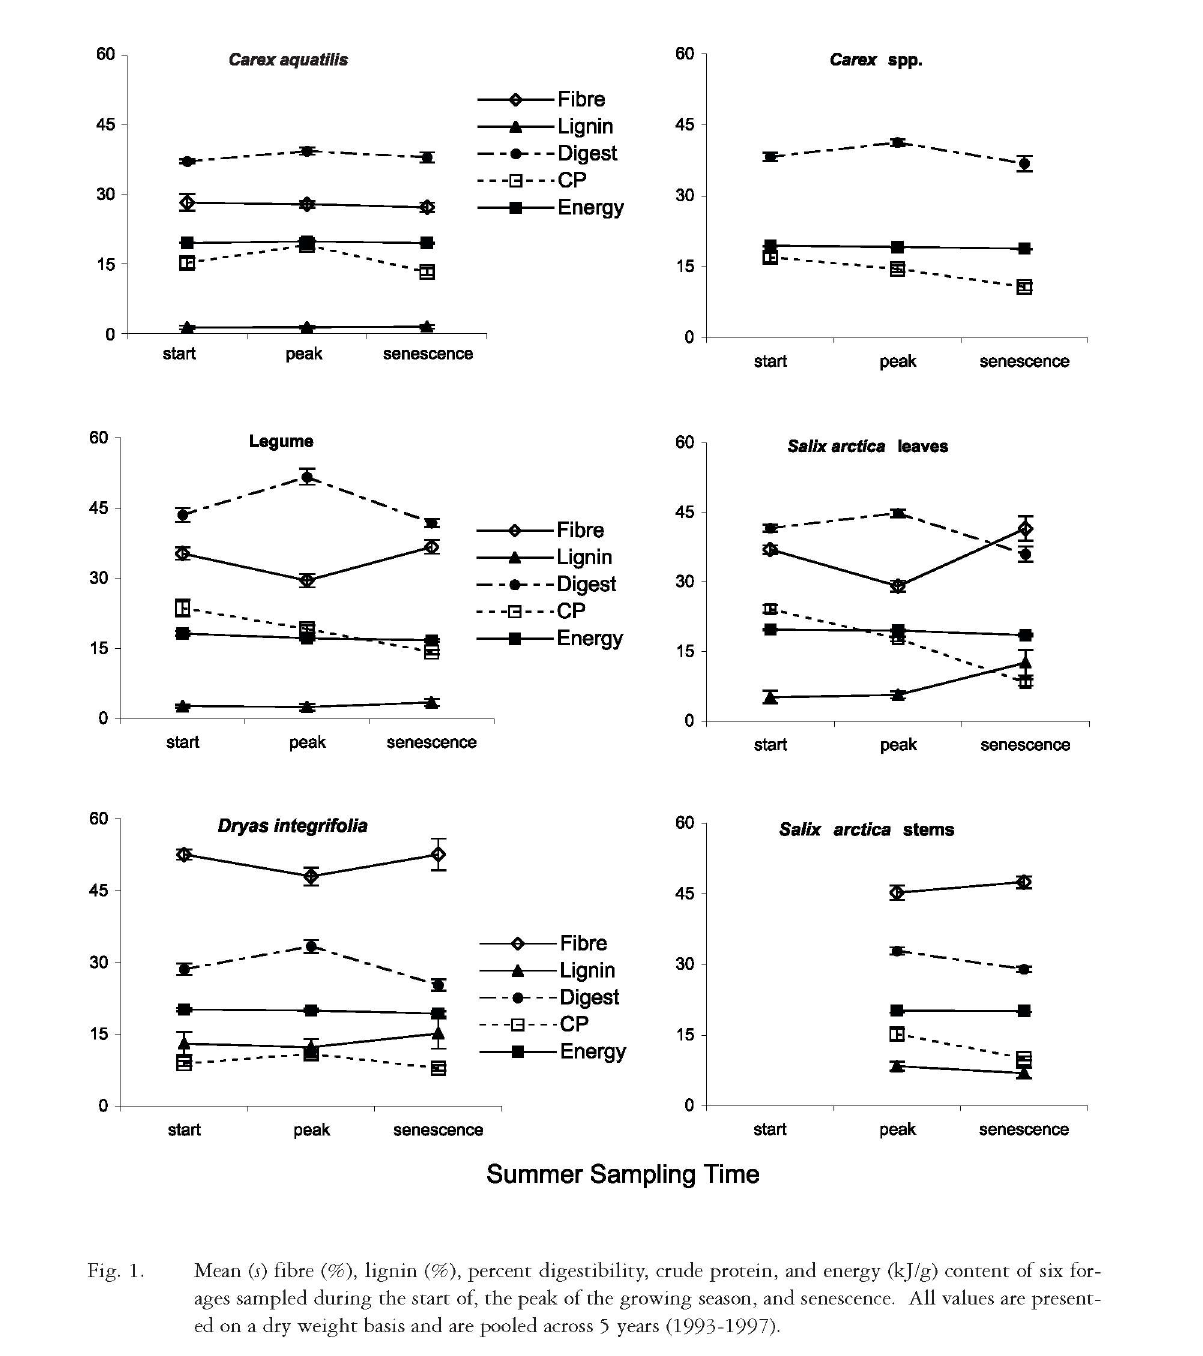
Fig. 1. Mean (s) fibre (%), lignin (%), percent digestibility, crude protein, and energy (kJ/g) content of six for¬ ages sampled during the start of, the peak of the growing season, and senescence. All values are present¬ ed on a dry weight basis and are pooled across 5 years